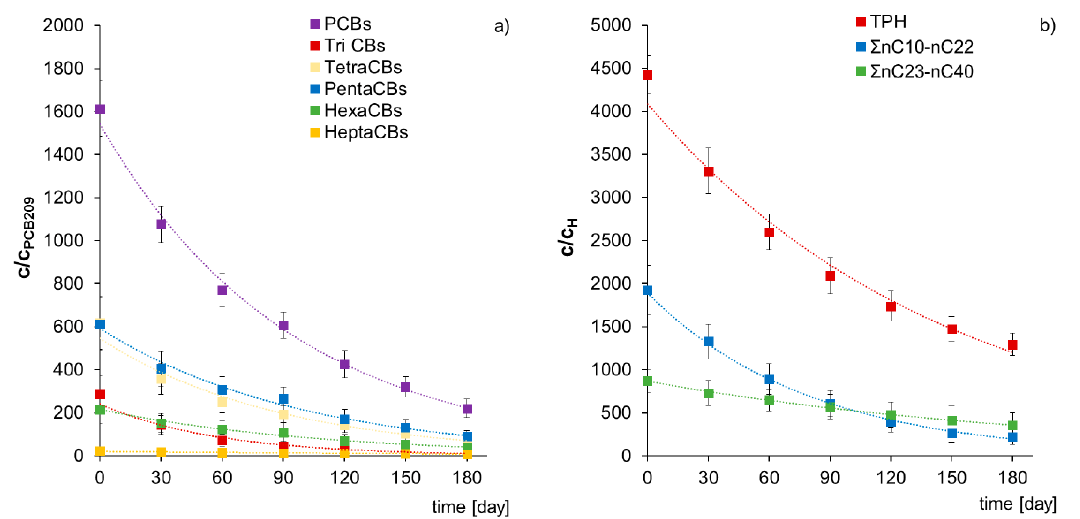
Figure 7. Comparison of content reduction ( a ) in PCB-209 normalized PCBs, TriCB, TetraCBs, PentaCBs, HexaCBs, and HeptaCBs ( b ) in hopane-normalized TPH, Σ nC 10 –nC 22 , and Σ nC 23 –nC 40 during inoculation of non-sterile soil D with mixed culture M1 (ex-situ prism method). (repetition number n = 7–10, p < 0.05).